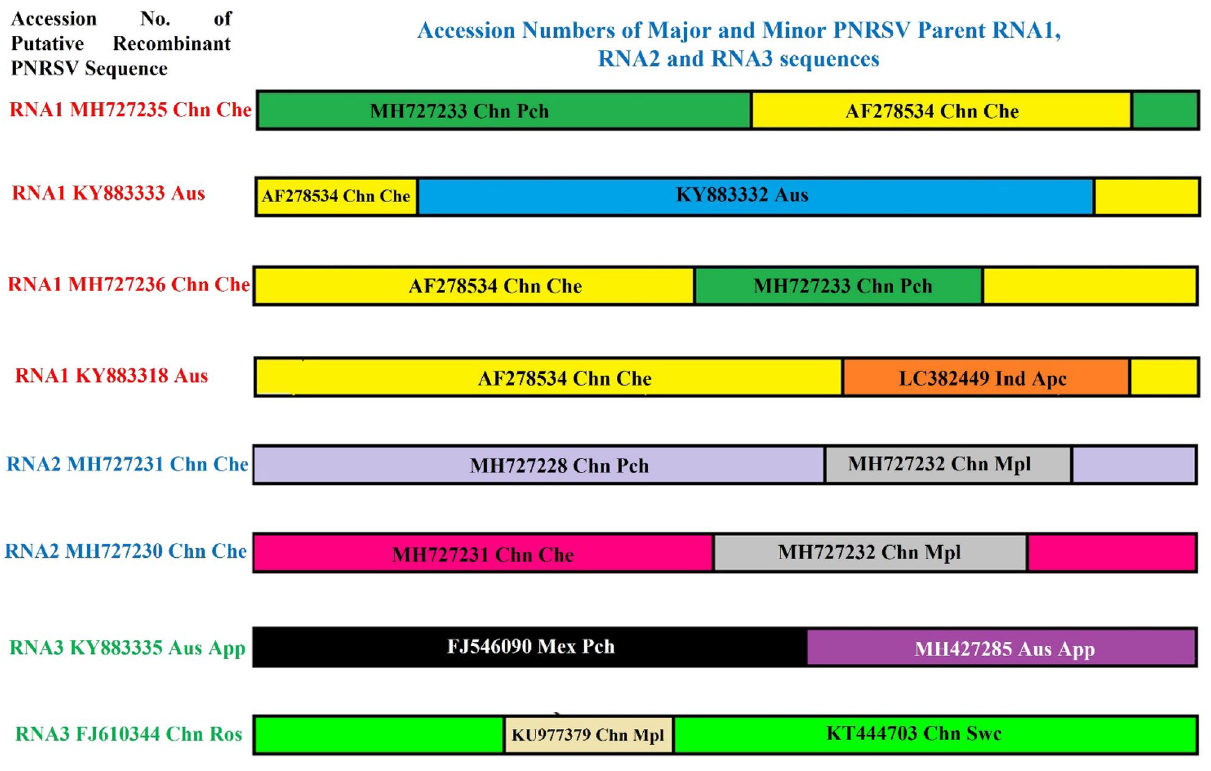
Figure 6. Recombination detection analysis of various isolates of